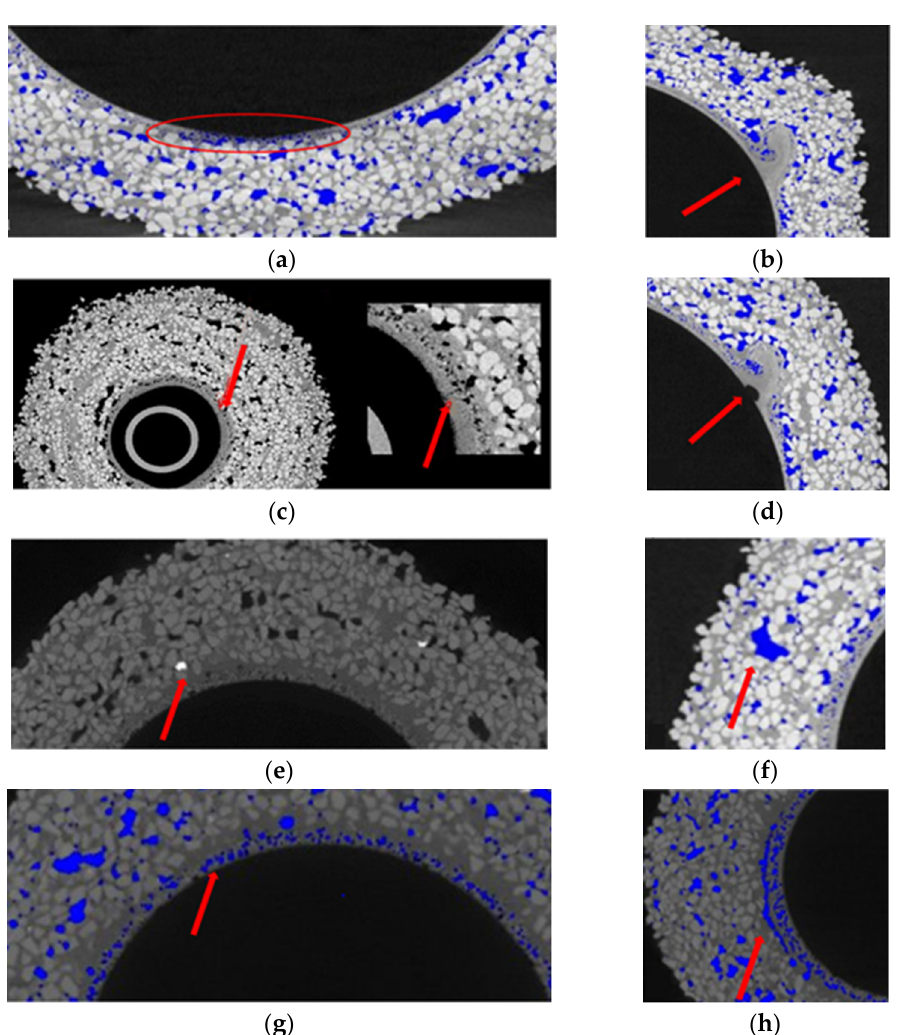
Figure 9. Defined spherical samples defects: open porosity ( a ), irregular material distribution in the first layer ( b ), local fracture of the first layer ( c ), misadjustment of the first layer to the wax model ( d ), material inclusions denser than mass components ( e ), large void ( f ) and local delaminations ( g , h ).